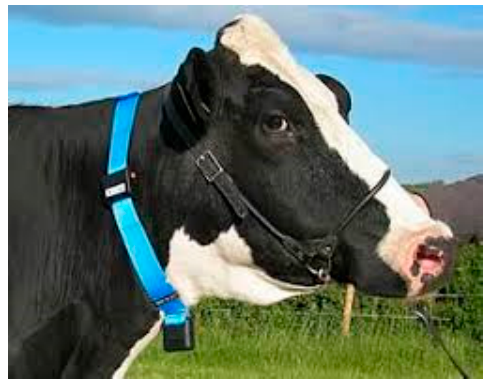
Figure 1. Silent Herdsman (Afimilk Ltd., Kibbutz, Afikim, Israel) 3-axis accelerometer based neck-mounted collar,